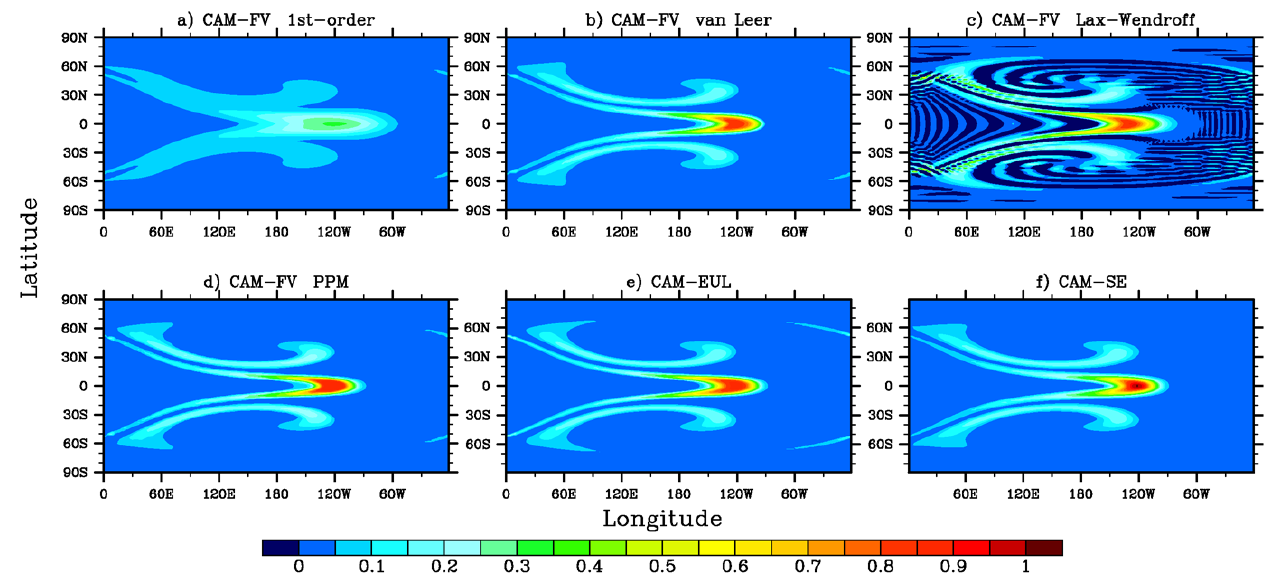
Fig. 6. Tracer mixing ratio results using CAM for test 1 at time t = T . CAM-FV using (a) first-order, (b) van-Leer, (c) Lax–Wendroff and (d) PPM with the default limiter, and (e) CAM-EUL, and (f) CAM-SE. These plots can be compared with the reference solution averaged onto the coarse resolution grid in Fig. 1. The maximum tracer mixing ratio values are (a) 0 . 311, (b) 0 . 832, (c) 0 . 854, (d) 0 . 886, (e) 0 . 865, and (f) 1 . 00. Note that the maximum of the CAM-FV reference solution averaged onto the 2 ◦ × 2 ◦ resolution grid is 0 . 9974.